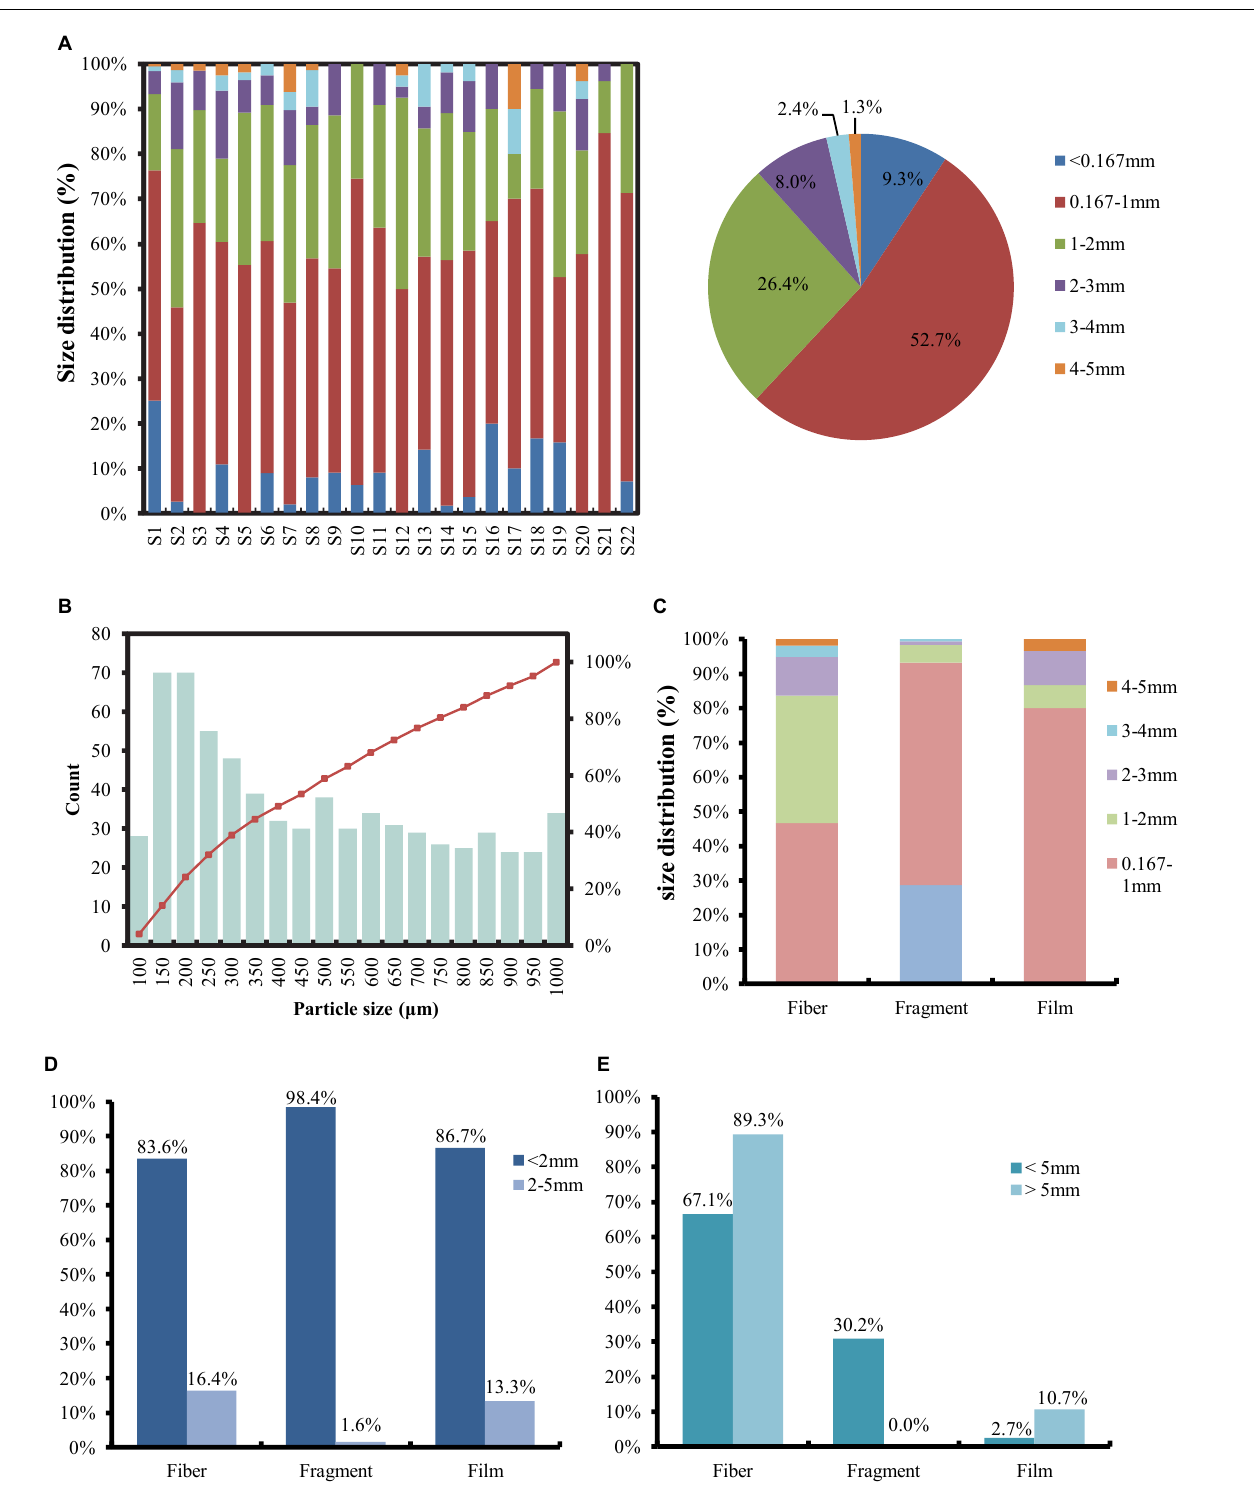
FIGURE 3 | (A) The size distribution of surface MPs around the southwestern SCS. S20, S21, and S22 were located around Zhongsha Island and Xisha Islands. (B) Frequency distribution and cumulative curve of MPs particles < 1 mm ( n = 696). (C) The size distribution of different MPs shapes: fibers, fragments, and films. (D) The percentages of different shapes between MPs < 2 mm and 2–5 mm. (E) The percentages of different shapes between MPs ( < 5 mm) and plastic debris > 5 mm.